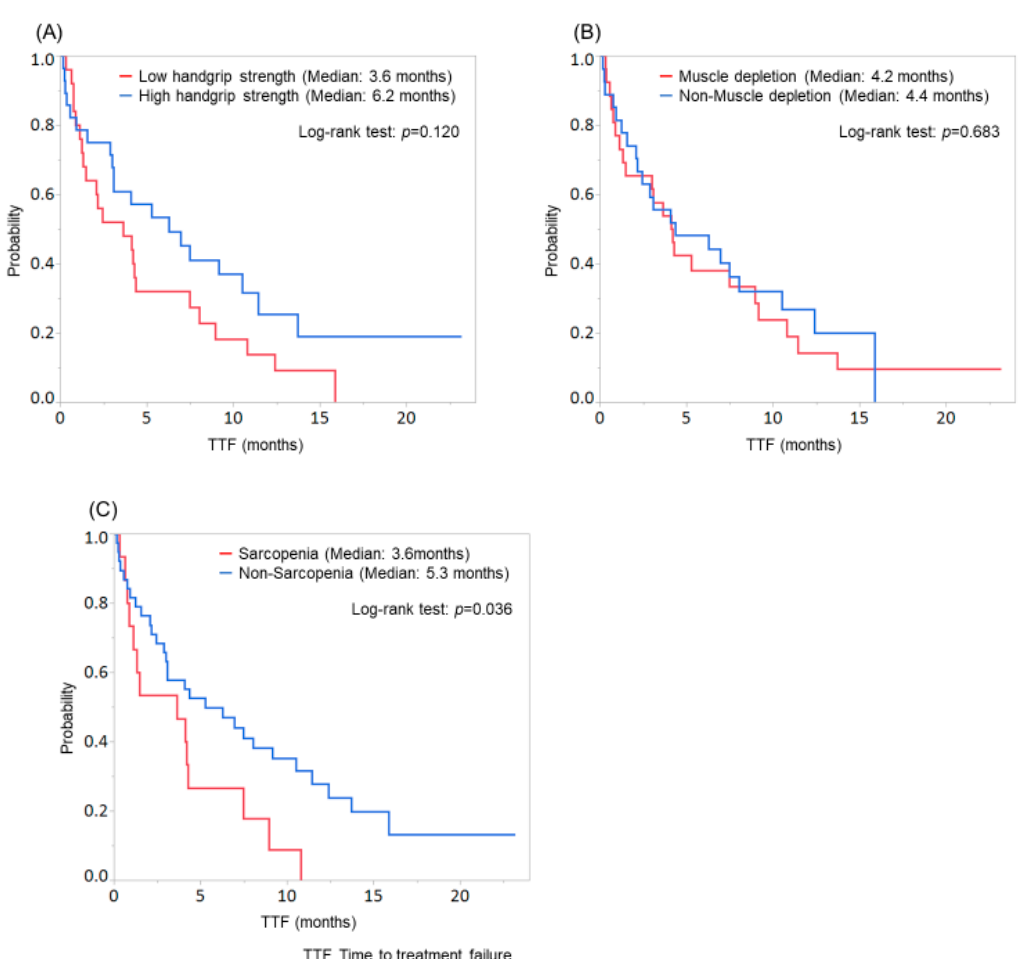
Figure 3. Comparison of time to treatment failure (TTF) according to the evaluation of handgrip strength, skeletal muscle, or sarcopenia. ( A ) Patients with low handgrip strength tended to discontinue the treatment than those with high handgrip strength (median TTF: low handgrip strength group, 3.6 months; high handgrip strength group, 6.2 months; p = 0.120). ( B ) No significant difference was found between patients with and without muscle depletion ( p = 0.683). ( C ) Patients with sarcopenia showed significantly worse TTF than those without sarcopenia (median TTF: sarcopenia group, 3.6 months; non-sarcopenia group, 5.3 months; p = 0.036).